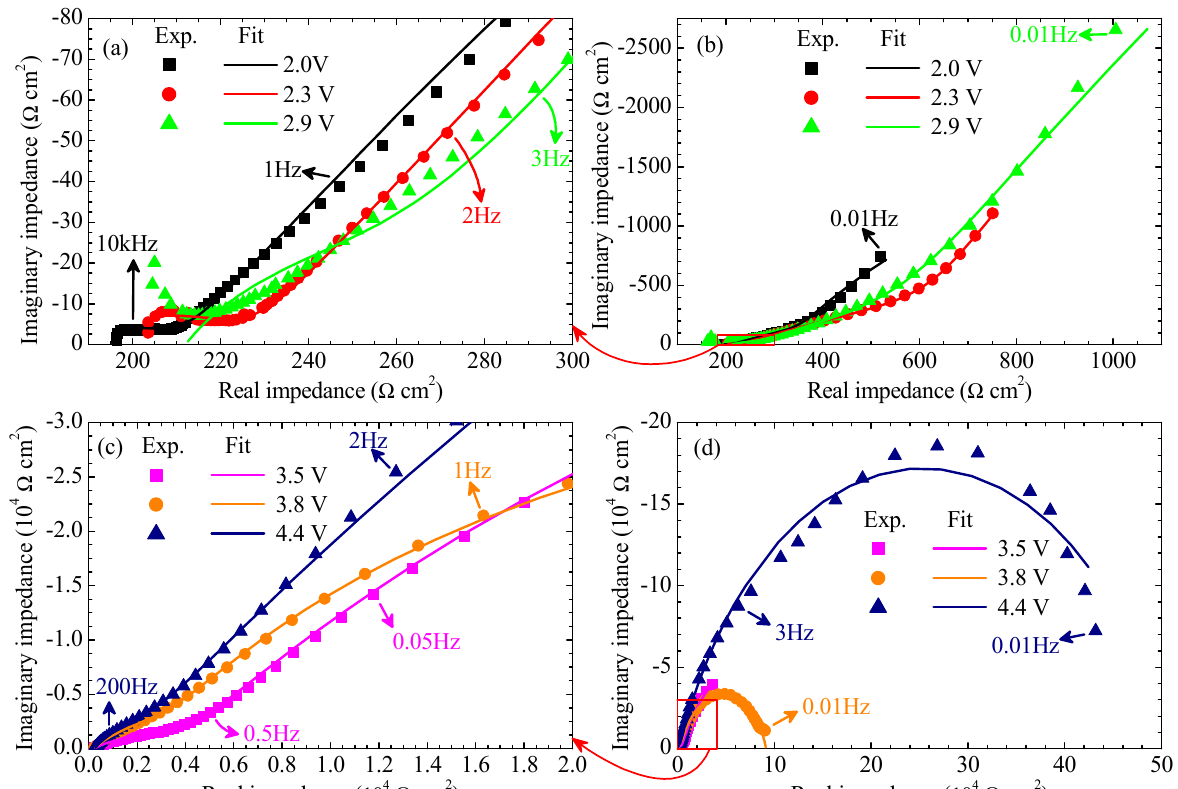
Figure 3. Real vs. imaginary impedance for a ~300-nm-thick HWO x film measured in a Li + -containing electrolyte: ( a , b ) at low potentials, and ( c , d ) at high potentials. Spectra were taken in the frequency range 10 mHz to 100 kHz at the shown potentials vs. Li/Li + . Some specific frequencies are marked in the figure. Measured data are denoted by symbols and full lines represent fits to equivalent-circuit models as described in the main text.